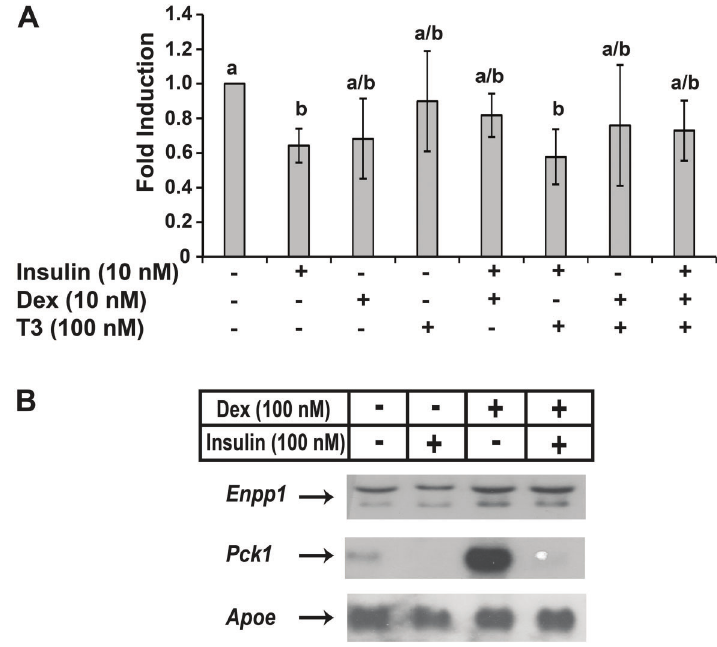
Figure 2. Total RNA was isolated and subjected to real-time PCR analysis ( A ) or northern blot ( B ). A , Expression levels of Enpp1 mRNA in primary hepatocytes treated with 10 nM insulin, 10 nM dexamethasone (Dex), 100 nM T3 or their combinations for 8 h (n=3 independent hepatocyte isolation and treatments). Data are reported as means ± SE. P o 0.05, different lower-case letters indicate statistical differences (one-way ANOVA). B , Expression levels of Enpp1 , Pck1 , and Apoe mRNA in primary hepatocytes treated with